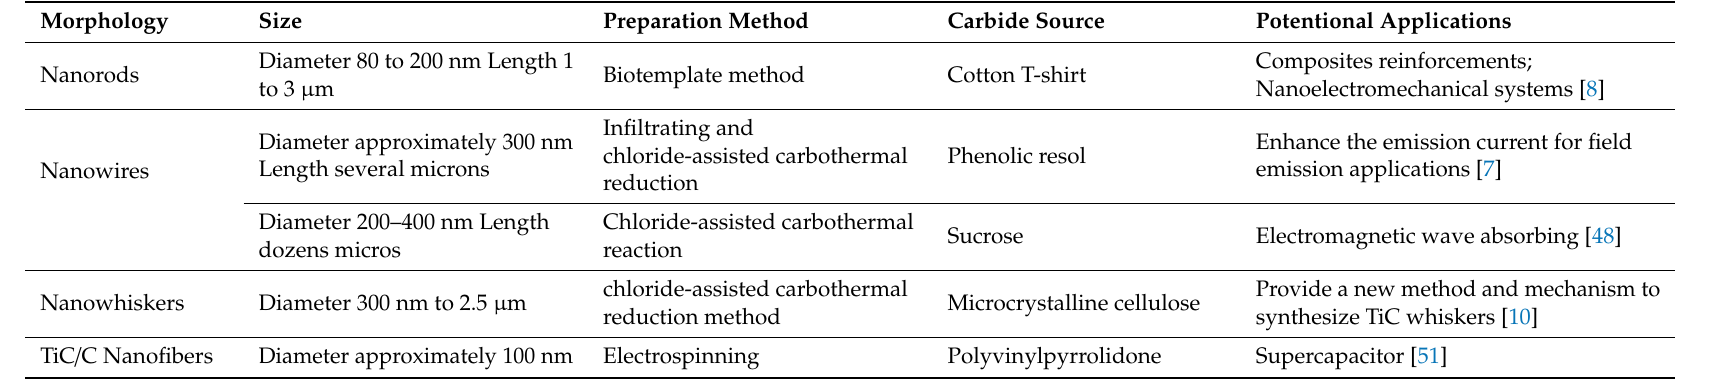
Table 1. Some nanoscale one-dimensional titanium